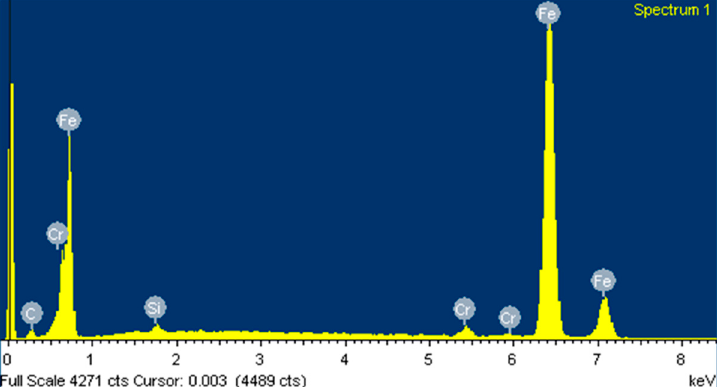
Figure 22. EDS spectrum of a non-tested area of the disc.